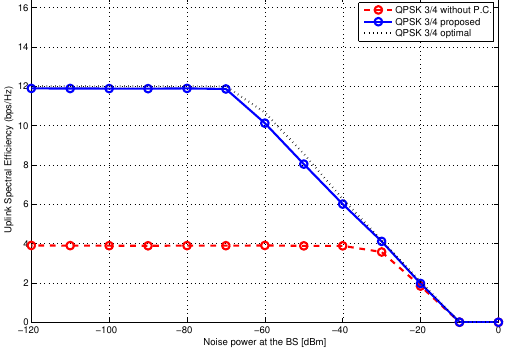
Figure 8. Spectral efficiency for QPSK-3/4 versus noise power.